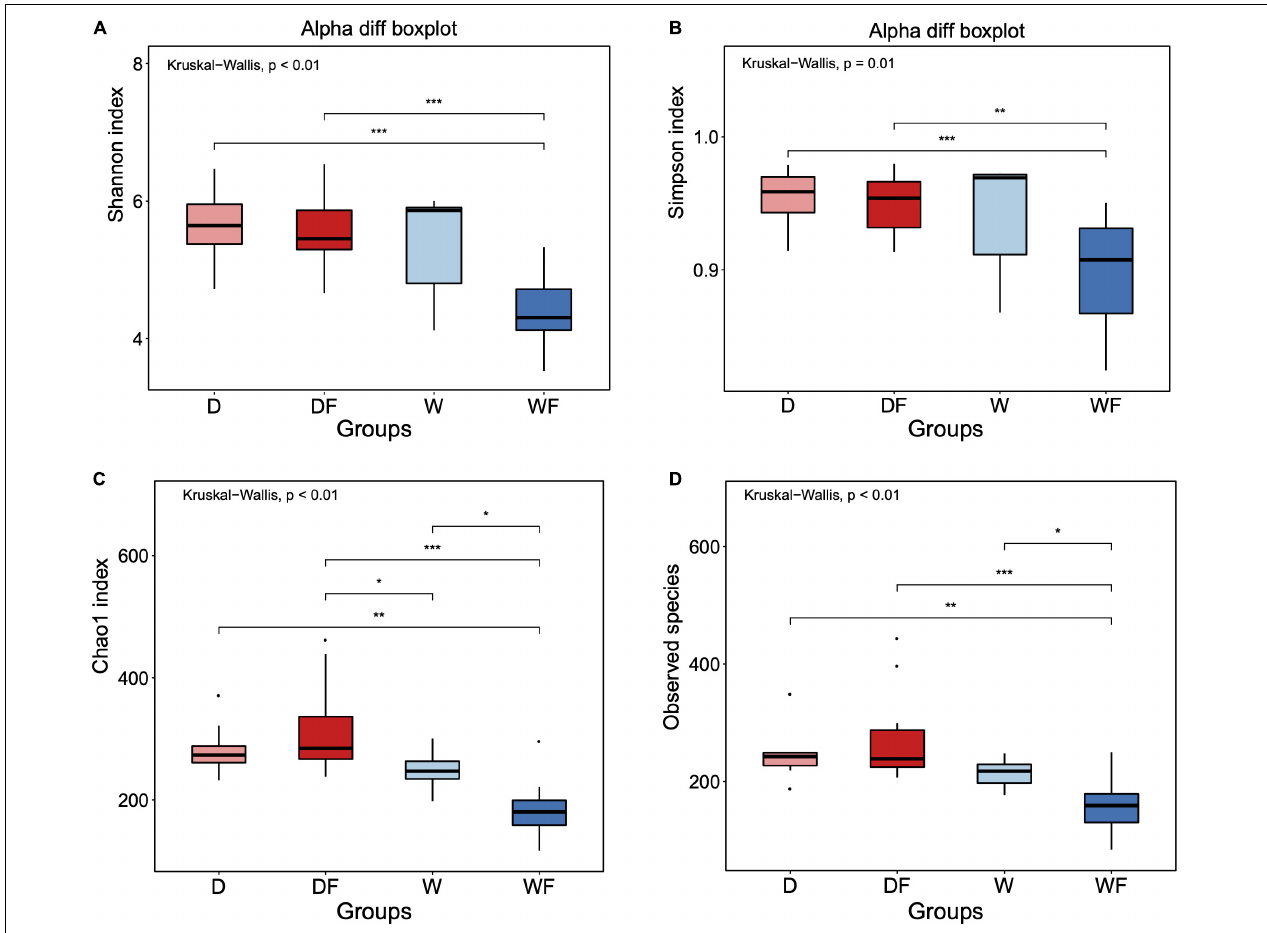
FIGURE 2 | Alpha diversity of (A) Shannon index, (B) Simpson index, (C) Chao 1 index, and (D) Observed species for gut microbiota diversity of mice transplanted domestic pig fecal bacteria and feed a low-fiber diet (D) or high-fiber diet (DF), transplanted wild boar fecal bacteria and feed low-fiber diet (W) or high-fiber diet (WF). * p < 0.05, ** p < 0.01, and *** p <